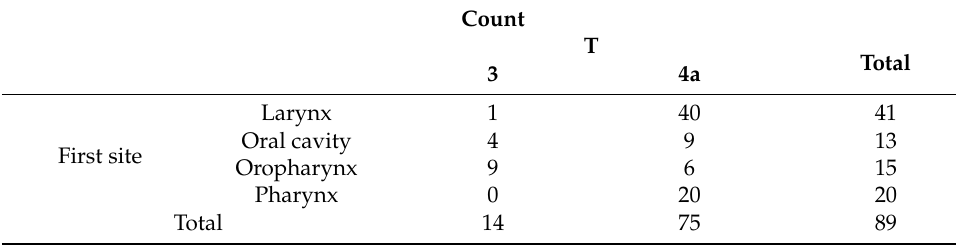
Table 2. Site of the primary tumour T.